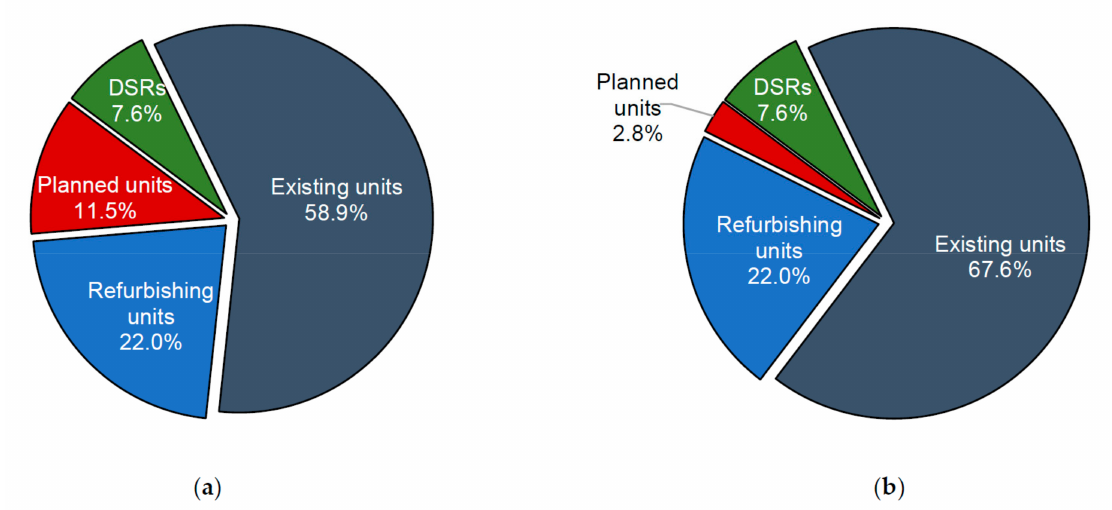
Figure 16. Structure of capacity obligation volumes contracted in main capacity auction for 2021–2025 delivery years–break down by capacity market units: ( a ) official (declared) assignment; ( b ) actual status of capacity market units. Source: Own analysis based on